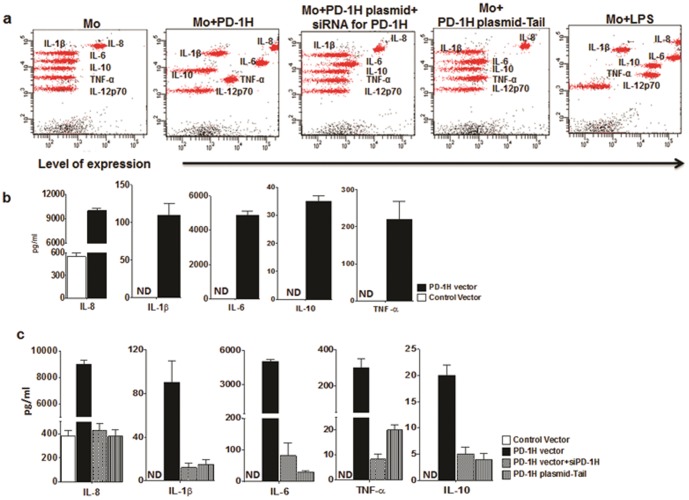
Spontaneous cytokine secretion by monocytes upon overexpression of PD-1H.Monocytes were nucleofected with control or PD-1H expression plasmid without or along with PD-1H siRNA or nucleofected with cytoplasmic domain deficient PD-1H as indicated and the culture supernatants tested for cytokine secretion by cytometric bead array (CBA) or ELISA. a) Representative result with monocytes from one donor (out of 10 donors tested) is shown. b) Supernatants from a) were also tested for individual cytokines by ELISA. Cumulative data from 10 donors are shown c) Cytokine secretion by monocytes in presence of PD-1H, PD-1H lacking cytoplasmic domain, PD-1H with its specific siRNA, vector alone and mock treatment as assessed by ELISA. ND, not detected.